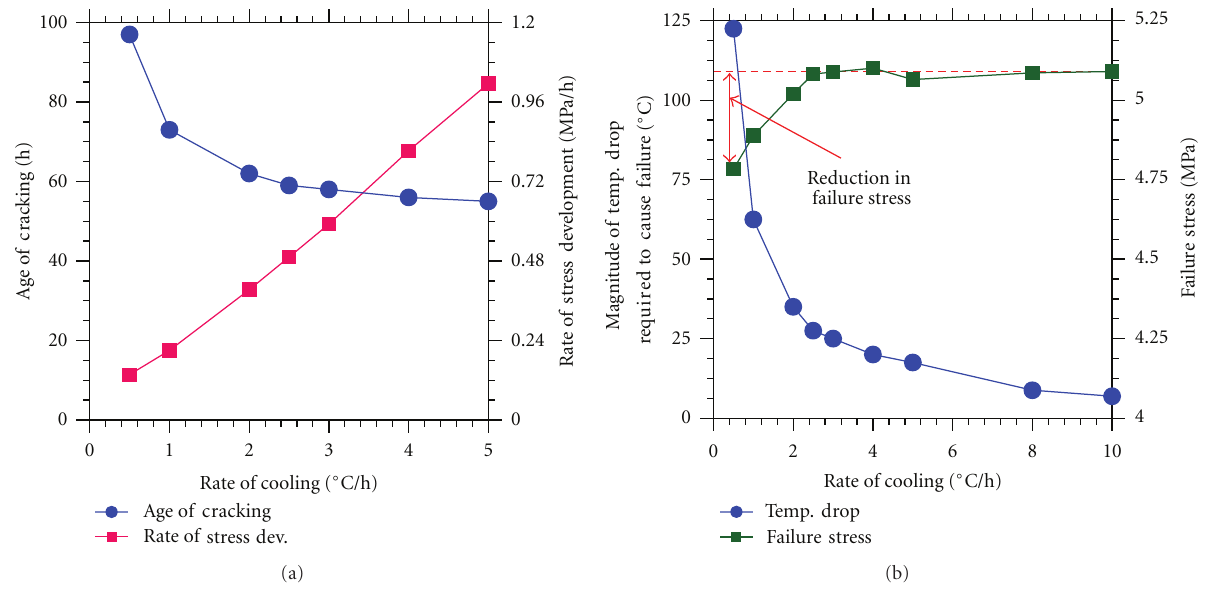
Figure 12: Influence of the rate of cooling on (a) the stress development and the age of cracking, and (b) the magnitude of temperature reduction and the average stress at failure in the dual ring